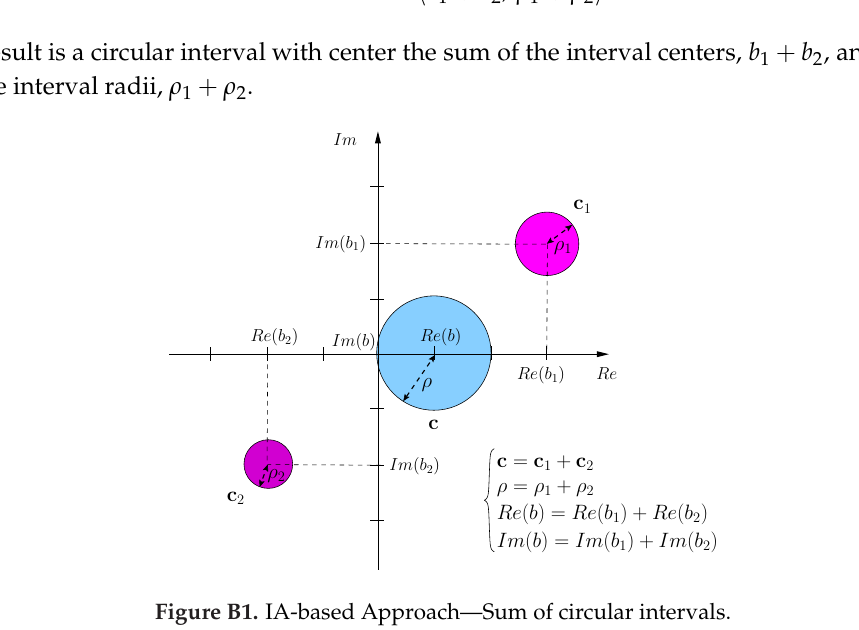
Figure B1. IA-based Approach—Sum of circular